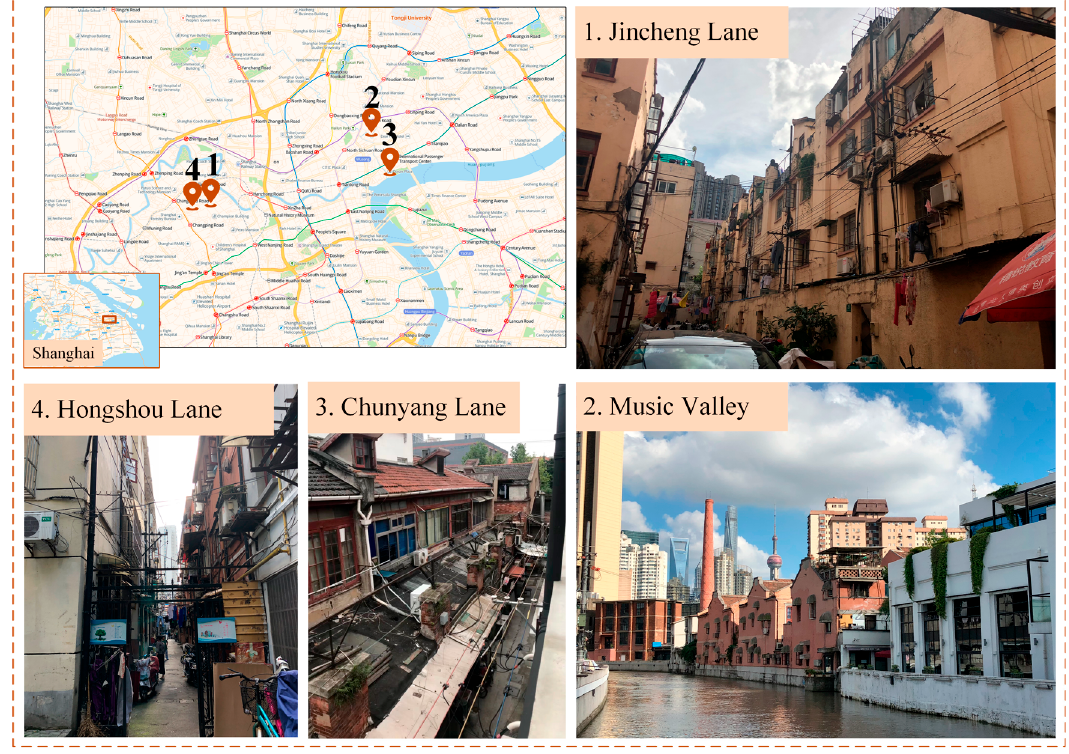
Figure 1. Locations of some of the projects